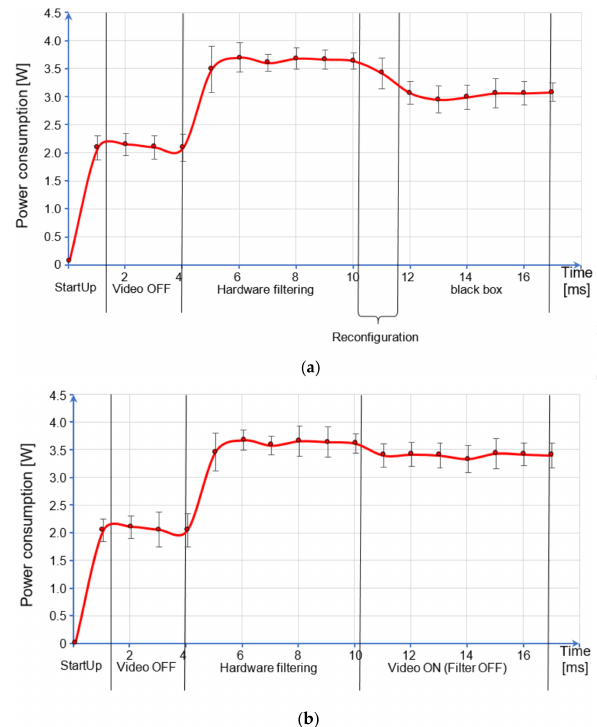
Figure 8. Power consumption versus time plot concerning the two different systems for the Sobel filtering DSP: ( a ) the dynamic partially reconfigurable architecture, and ( b ) the static architecture. For each reported value, obtained as average of the 15 performed measurements, the error bar denoting the standard deviation is also shown.